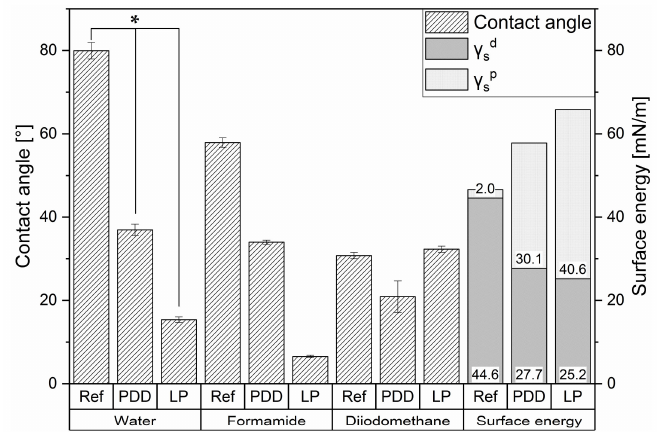
Figure 3. Comparative plot of the resulting contact angle of different test liquids (water (ANOVA tested, p = 0.05 indicated by *), formamide, diiodomethane) and surface energies on PEEK after surface modification using atmospheric (PDD, 18 W, 120 s, 10 mm,) and low-pressure plasma (LP, 100 W, 120 s, 2 sscm) ( n = 10).